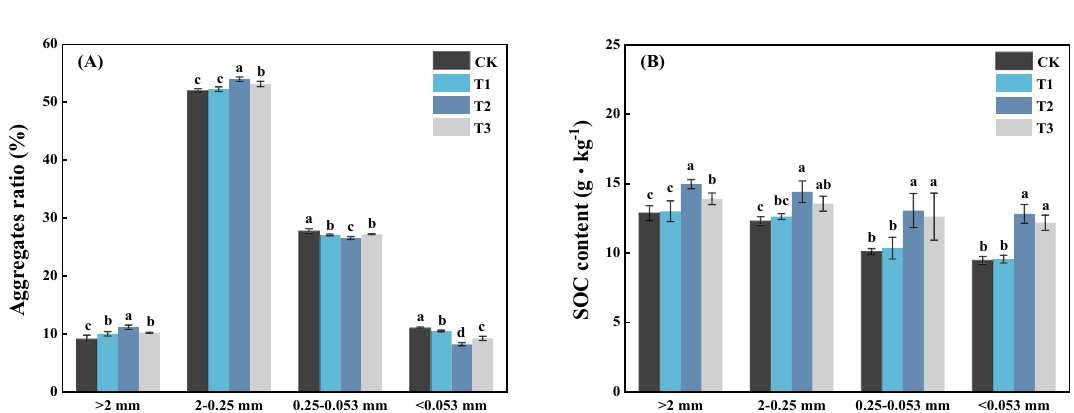
Figure 1. Effect of different treatments on soil agglomerate composition (A) and SOC content (B) . Different letters indicate significant differences at P < 0.05 (according to Duncan’s multiple range